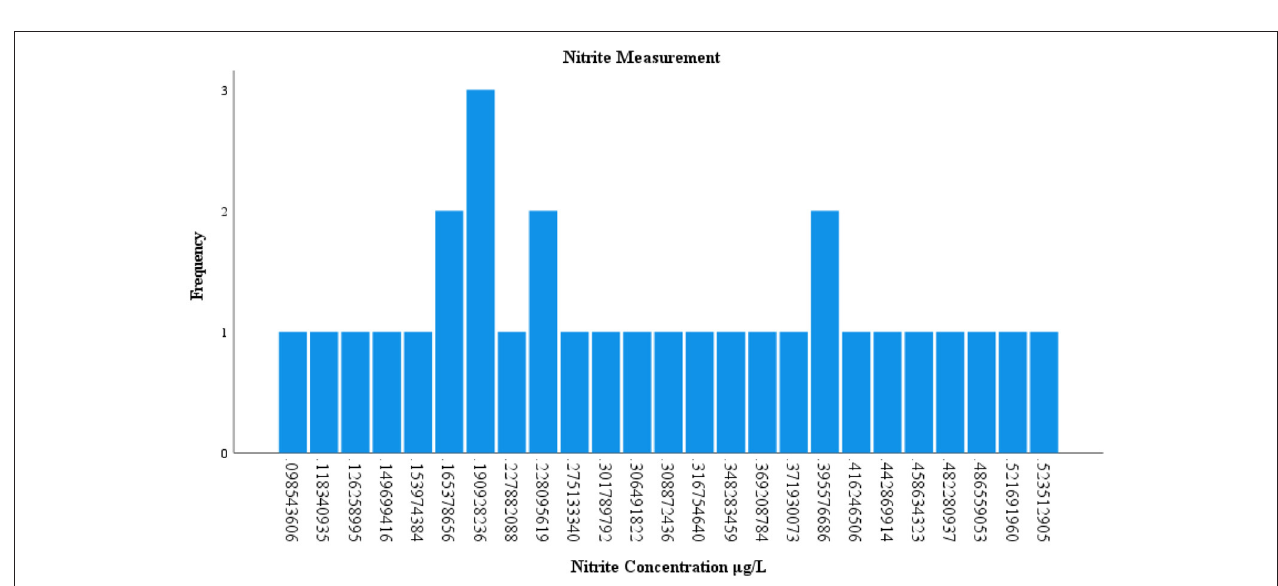
FIGURE 5 | Measurement of nitrite in Lake